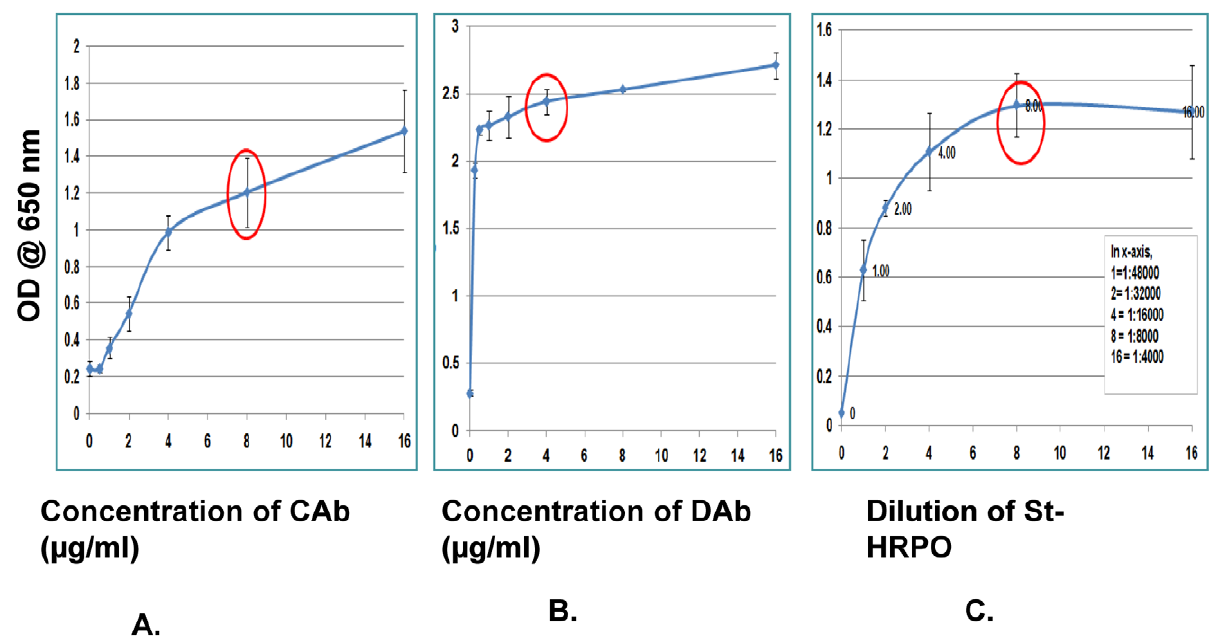
Figure 3. Optimization of different assay parameters. A: Optimisation of the capture antibody (CAb), where the concentration 8 m g/ml was found to be optimum. B: The optimisation of detection antibody (DAb), where the concentration 4 m g/ml was found to be optimum. C: The optimisation of conjugate (st-HRPO), where the dilution 1:8,000 was found to be optimum.